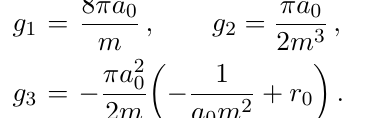
Figure 1. Diagrams contributing to the non-relativistic scattering amplitude T ( p 0 to and including O ( p 3 ) . The shaded squares stand for vertices with the non-derivative coupling g 1 , the filled circles for the vertices with derivative couplings g 2 , g 3 , and the cross corresponds to the relativistic insertion p 4 / (8 m )